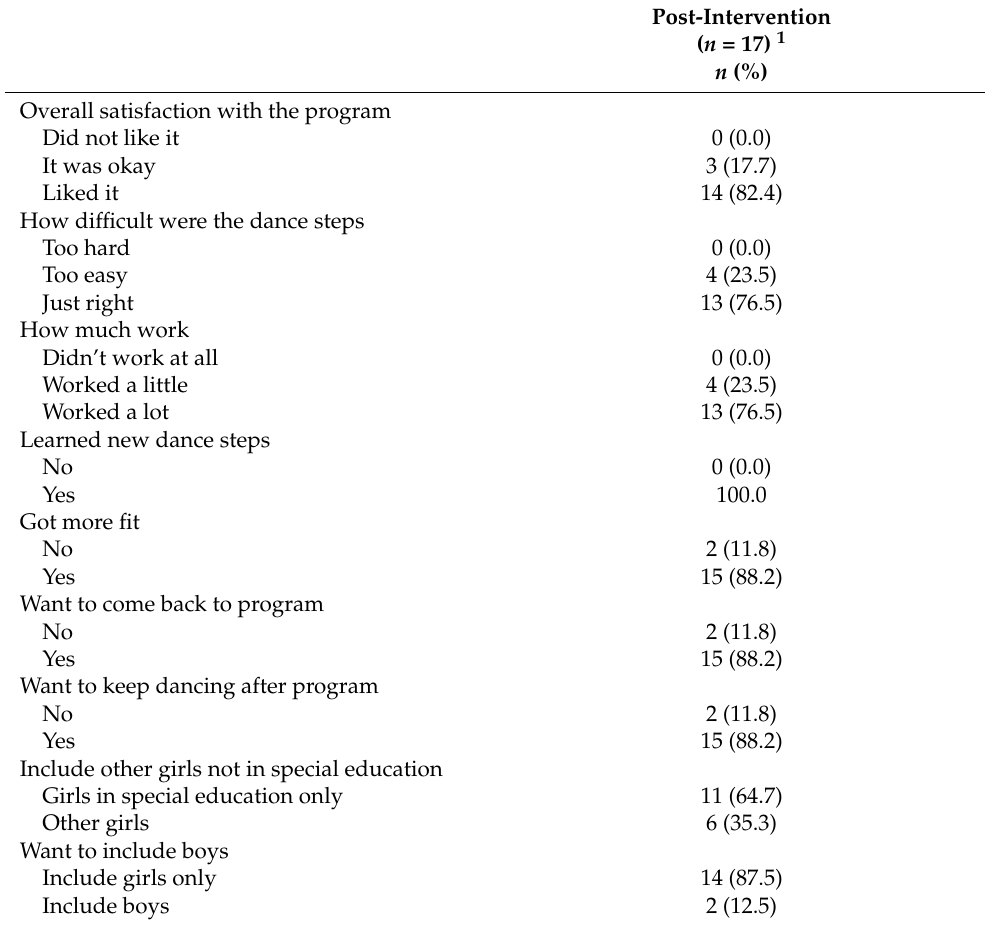
Table 4. Assessment of participant satisfaction with the dance intervention program post- intervention.